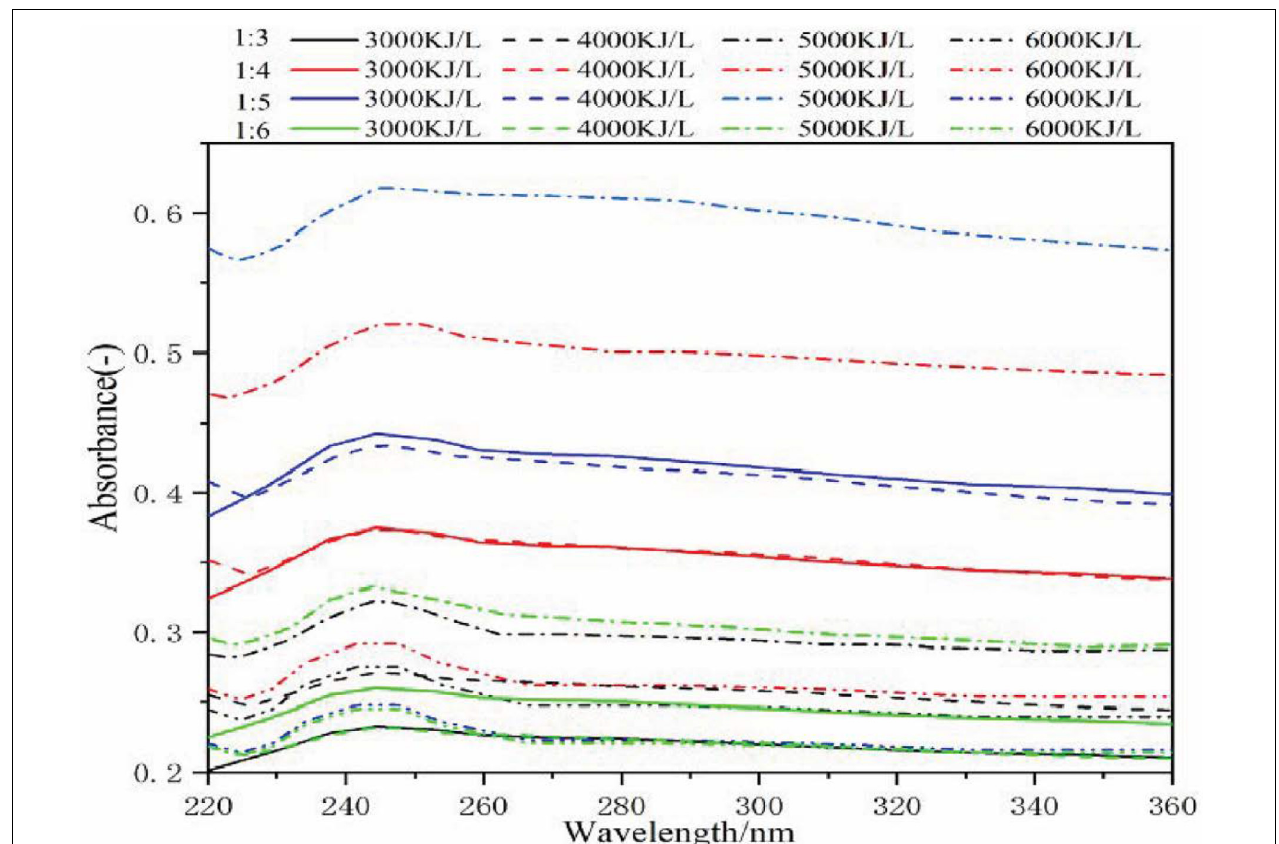
FIGURE 4 | Absorbance of CNFs suspension with different energy density and weight ratio of CNFs to surfactant.